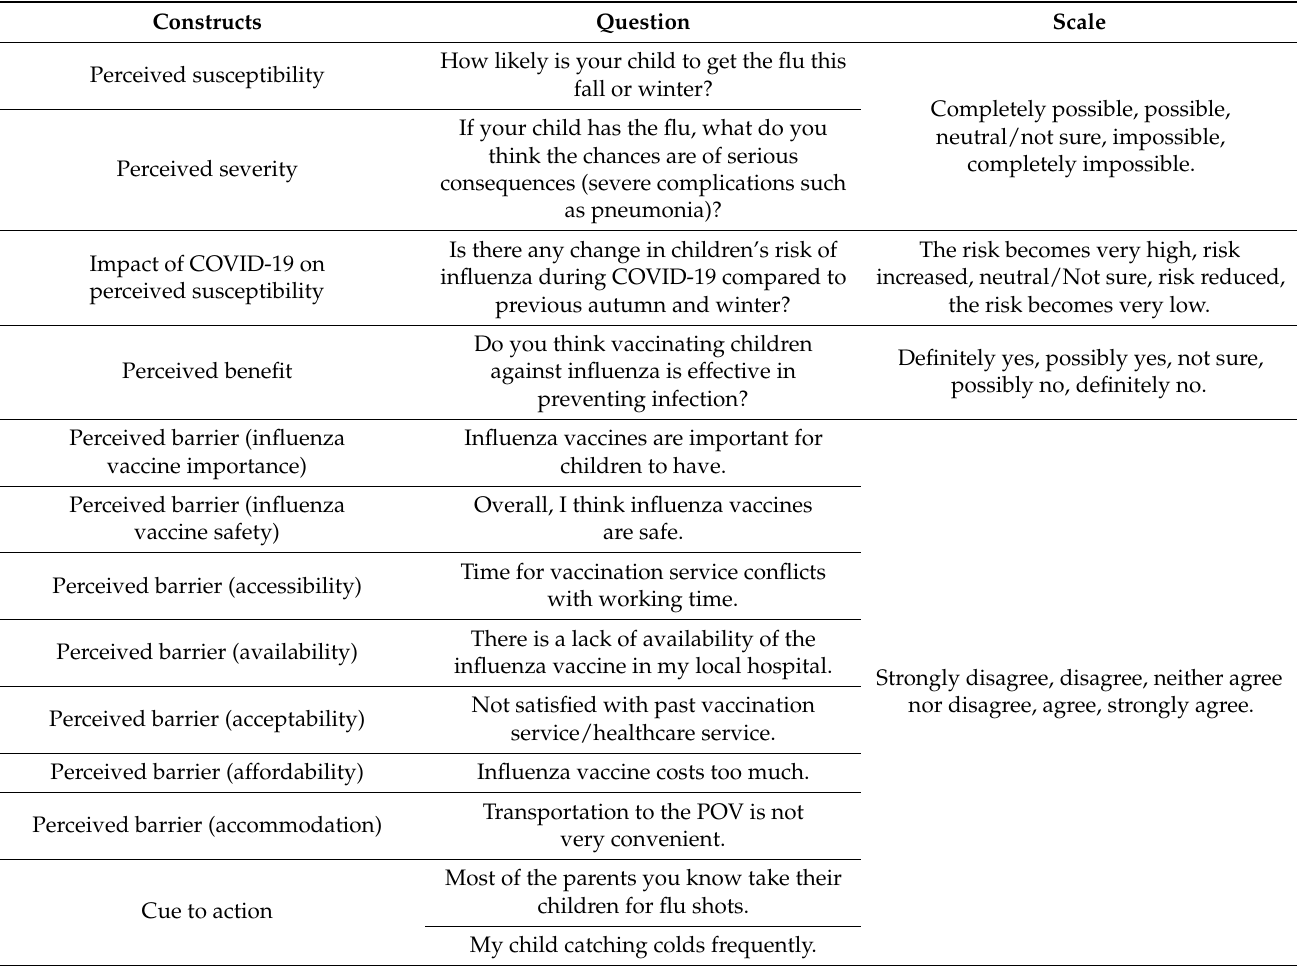
Table A1. Construction and corresponding questions used to measure the perception of influenza vaccine and disease and cue to action of caregivers.